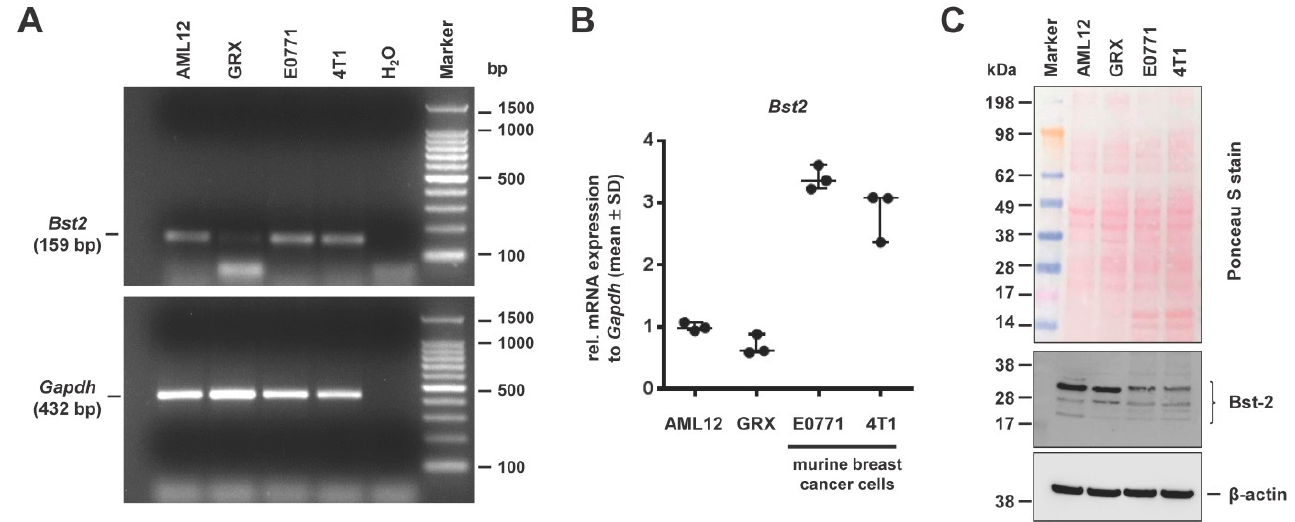
Figure 5. Expression of bone marrow stromal antigen 2 (Bst-2) in GRX. GRX cells were analyzed for Bst-2 expression by using AML-12 and murine breast cancer cell lines E0771 and 4T1 as positive controls. ( A ) Agarose gel electrophoresis of amplicons derived by RT-PCR showed a 159 bp product for Bst2 in all analyzed cell lines. RT-PCR product of Gapdh (432 bp) served as control. ( B ) Quantitative mRNA expression analysis of Bst2 by RT-qPCR verified expression in all cell lines. In this analysis, the relative mRNA expressions (measured in triplicates) were normalized to Gapdh expression. Values are given in relation to AML12 cells. ( C ) Western blot analysis confirmed Bst-2 protein expression. The Ponceau S stain is shown to demonstrate the integrity of proteins, and β -actin re-probing served as internal loading control. Please note, that for Bst-2 protein, more than one band (between 17–38 kDa) was visible, most likely due to post-translational modifications such as glycosylation.